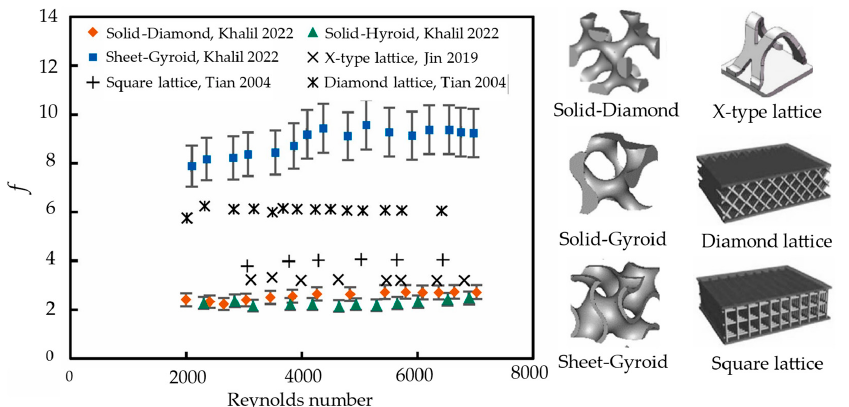
Figure 20 . Comparisons of friction factor of the TPMS structures with other periodic cooling structures [48]. Solid-Diamond [48], Solid-Gyroid [48], Sheet-Gyroid [48], Square lattice [89], Diamond lattice [89], X-type lattice [90]. The globally averaged Nusselt number ratio ( 0 Nu Nu ) with friction factor ratios ( f / f 0 ) for different geometries are plotted in Figure 21 to compare the relative performance of the cooling structures. The results show that the solid-Diamond structure provides the highest Nusselt number ratio, up to 8.0–10.0, with the friction factor ratios between 55.0– 75.0. The solid-Gyroid structure shows lower Nusselt number ratios to the solid-diamond structure with similar friction factor ratios. The sheet-Gyroid structure also generates higher Nusselt number ratios than the micro-lattice structures but causes high friction